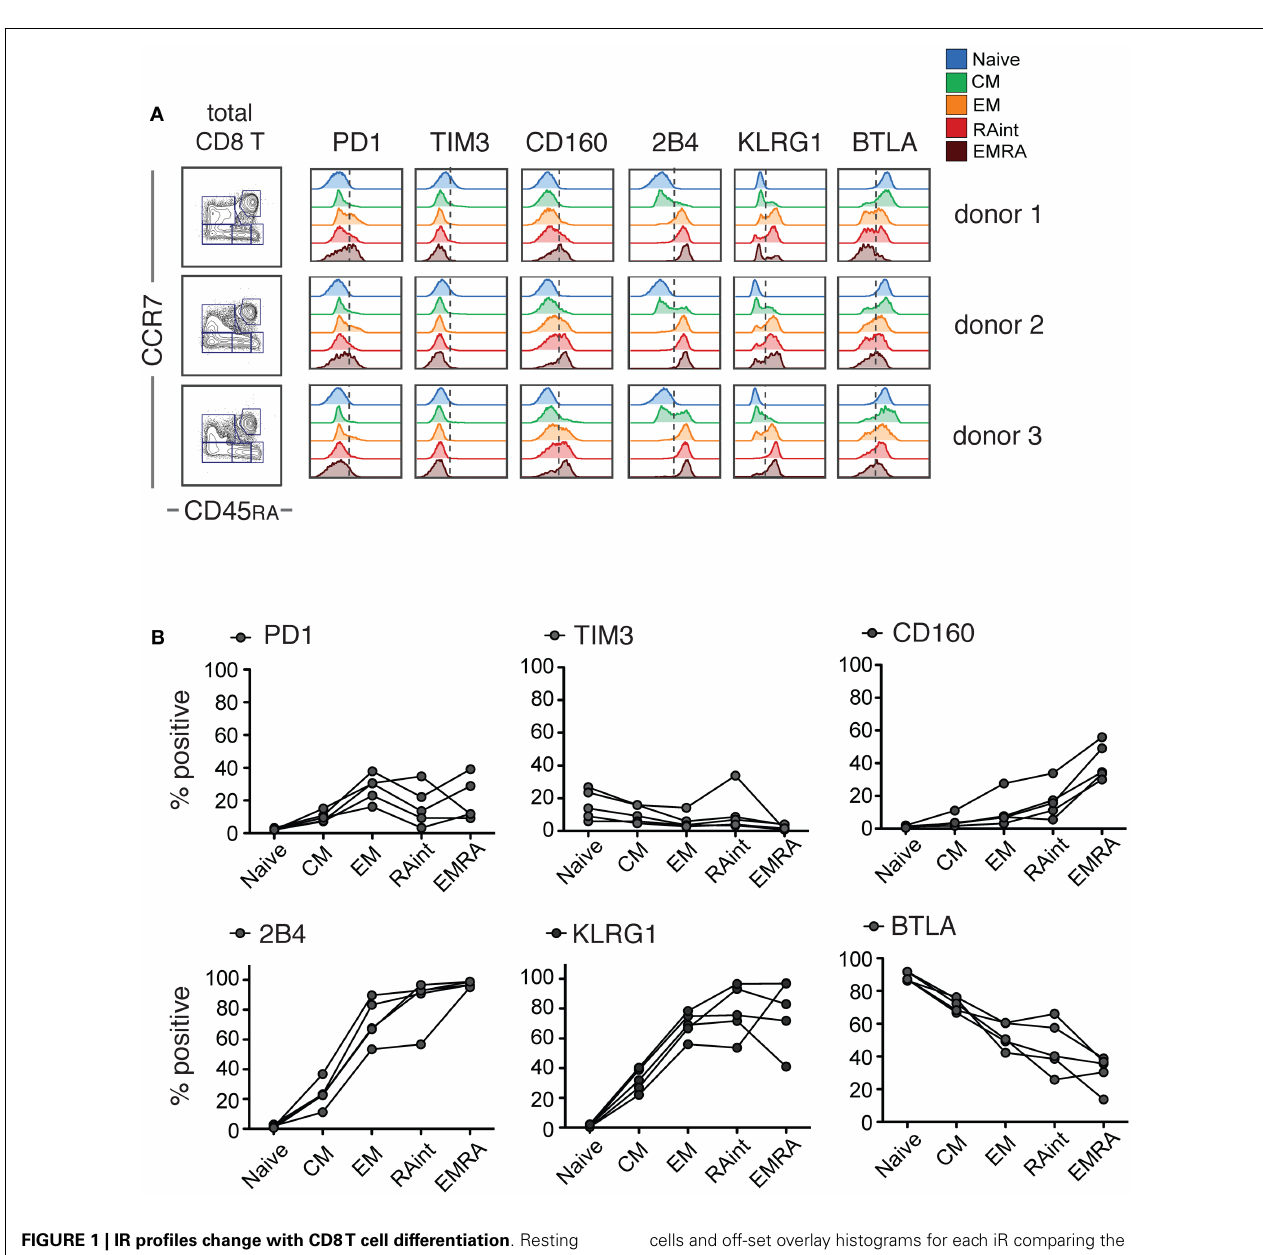
FIGURE 1 | IR profiles change with CD8T cell differentiation . Resting CD8T cells isolated from healthy donor PBMC were analyzed for the indicated inhibitory receptors (iRs) (these samples correspond to the medium controls from the experiments in Figure 2 ).Three examples are shown. (A) . CCR7 versus CD45RA-based differentiation plot of total CD8T